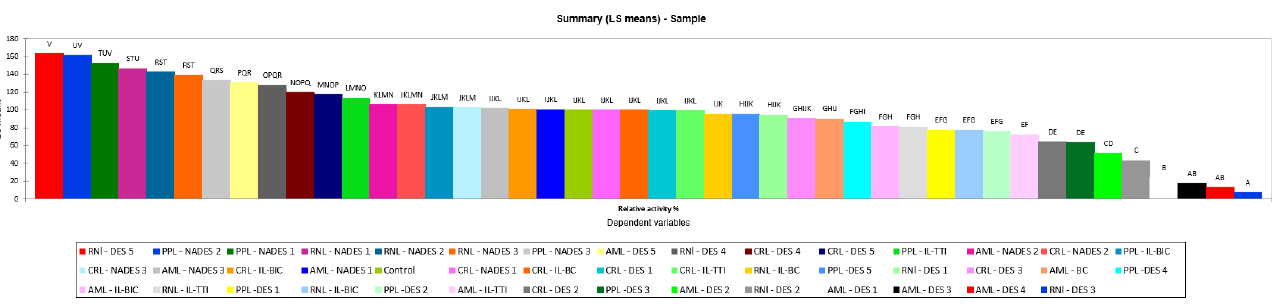
Figure 4. Relative lipase activity of CRL, AML, RNL, and PPL in solvents and co-solvents. CRL = Candida rugosa lipase, ≥ 700 U mg − 1 solid, AML = Amano lipase PS, from Burkholderia cepacian , ≥ 30,000 U g − 1 ), RNL = Rhizopus niveus lipase, ≥ 1.5 U mg − 1 ), and PPL = porcine pancreas lipase, 100 – 500 U mg − 1 protein.